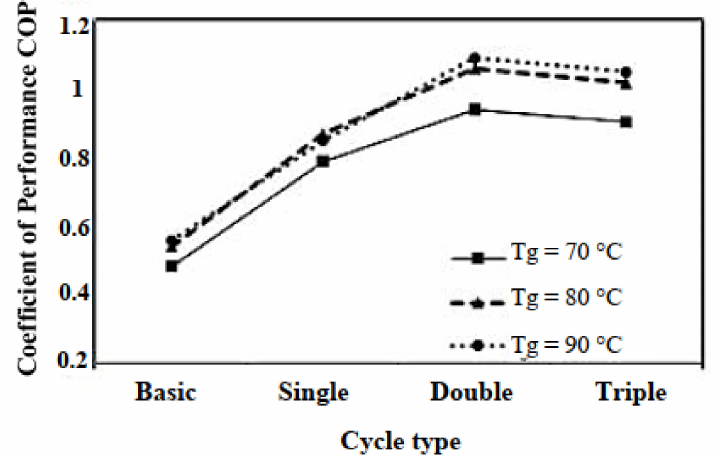
Figure 14. COP for different system designs at different generator temperatures [74].